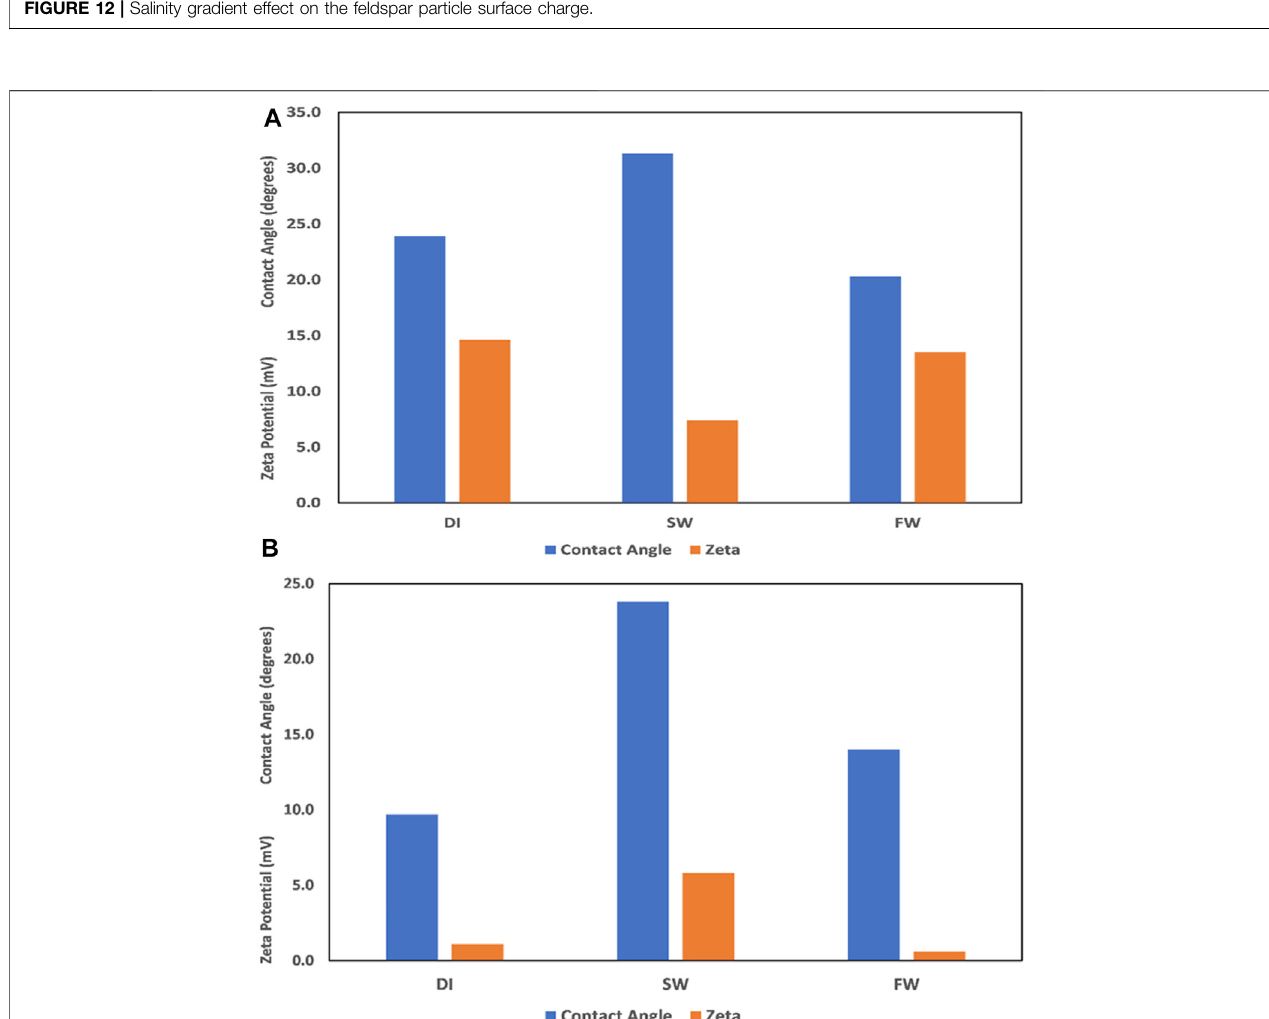
FIGURE 13 | Contact angle measurements in DI, FW, and SW. (A) Barite and (B) dolomite.